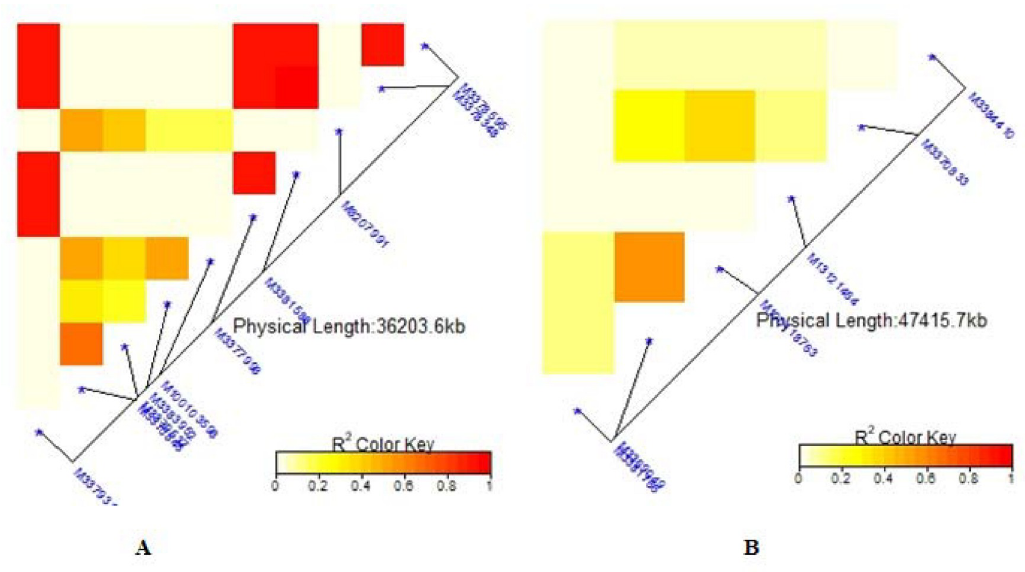
Fig 9. Summary of local LD among markers with significant marker trait associations of 99 common bean genotypes. Note: A = Days to 50% flowering (DTF), B = Days to 90% physiological maturity (DTM). The R 2 colour key indicates the degree of significant